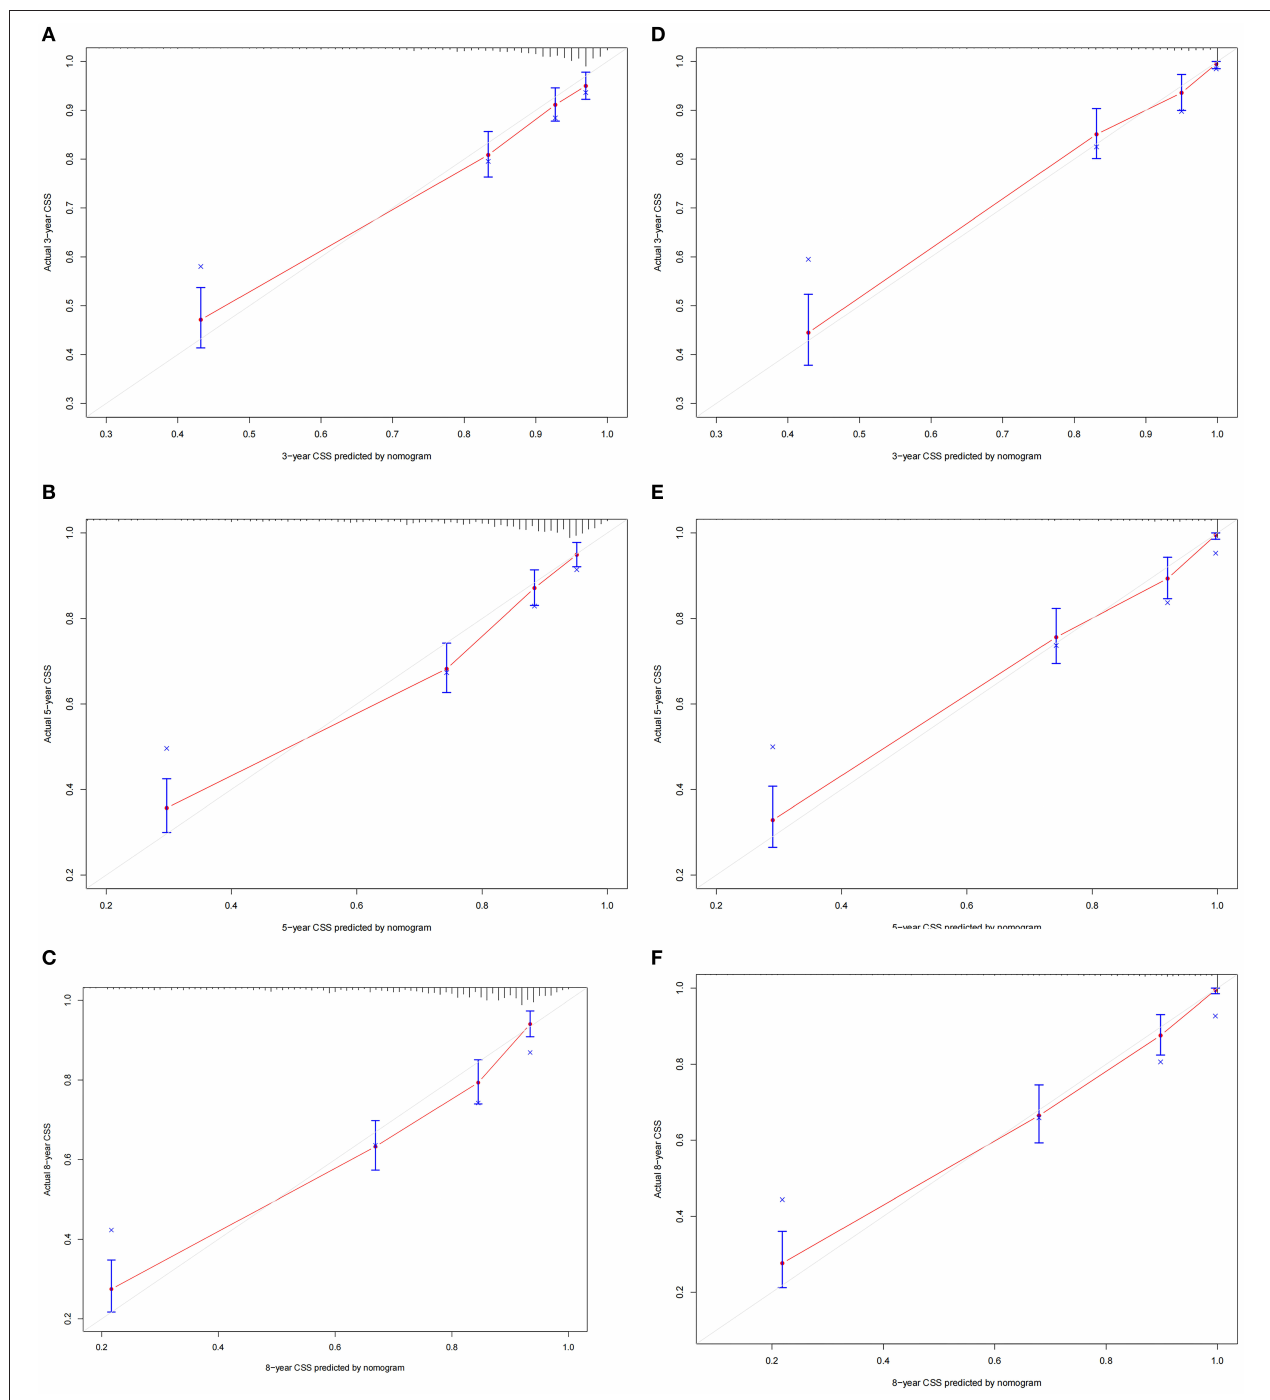
FIGURE 3 | Calibration curve of the nomogram. (A–C) For 3-, 5-, and 8-year CSS in the training set; (D–F) for 3-, 5-, and 8-year in the validation set.